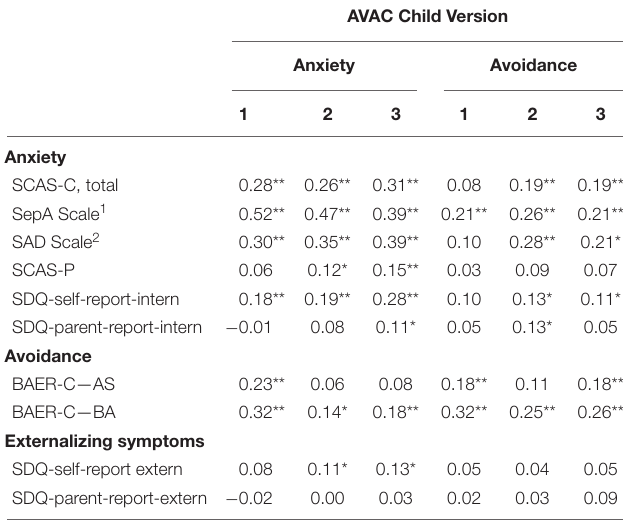
TABLE 2 | Correlations between the AVAC child version and other measures of anxiety symptoms and avoidance (convergent validity) as well as externalizing symptoms (divergent